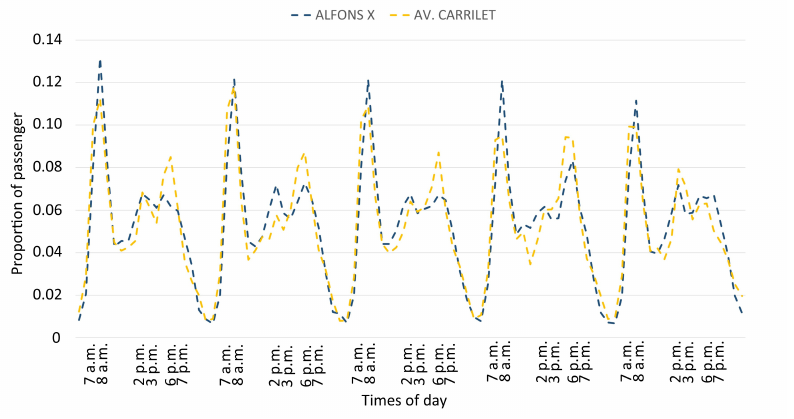
Figure 14. Pattern of boarding in stations in cluster 3 with morning and afternoon rush hour on